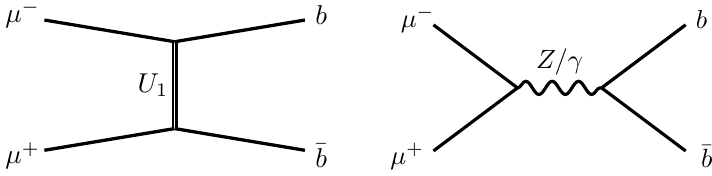
Figure 10 . Contribution to DY dijet production from LQ exchange (left) and SM (right). We can use the interference of these two diagrams to look for the LQ